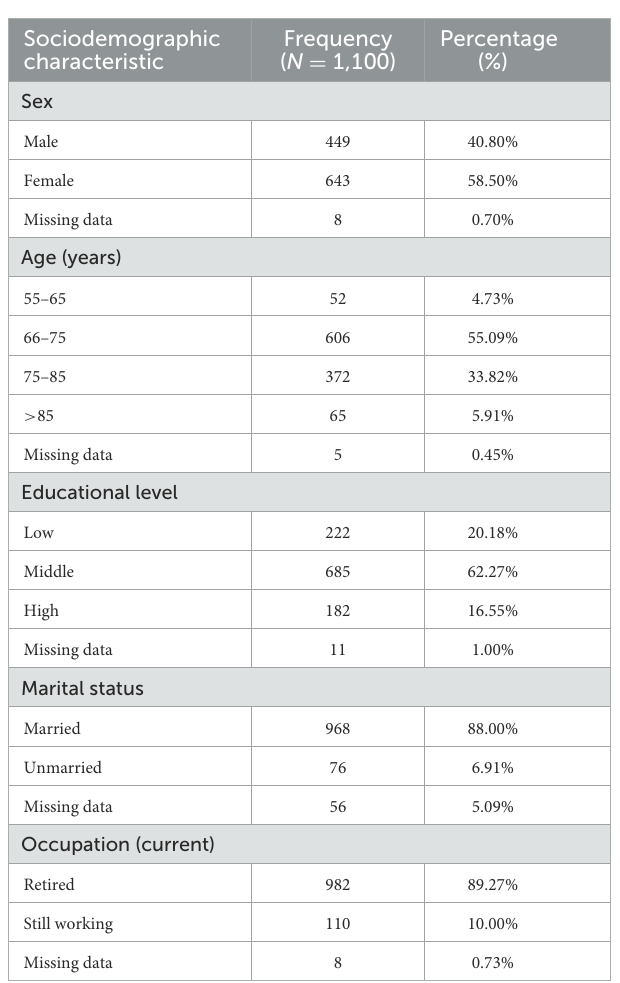
TABLE 1 Sociodemographic characteristics of